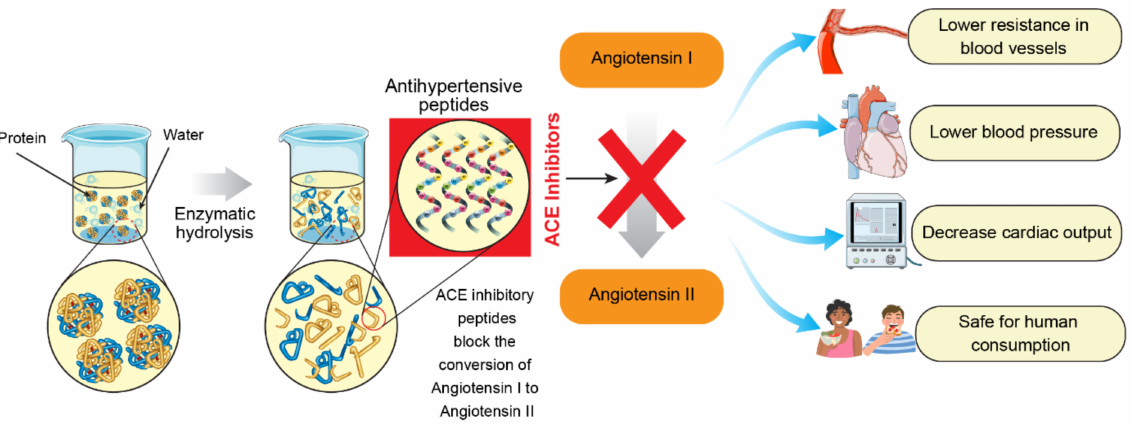
Figure 2. Schematic illustration of preparation and mechanism of action of ACE-inhibitory peptides. Table 3. ACE-inhibitory, antimicrobial, and antiproliferative peptides from food